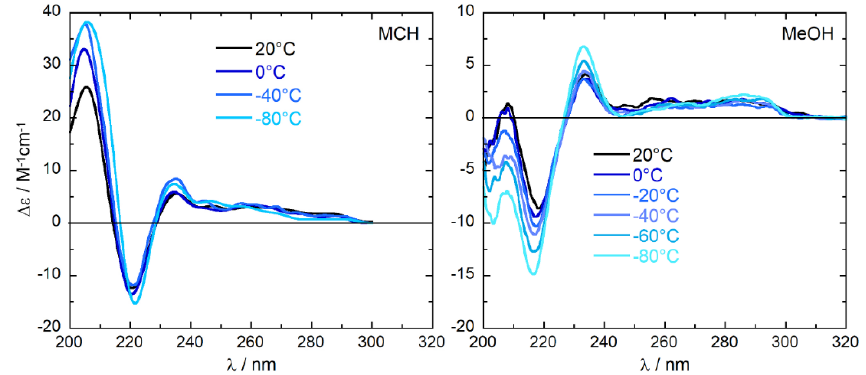
Figure 3. ECD spectra of ( R )-tolterodine ( 1 ) measured in MCH and MeOH at variable temperatures. Concentration 1.67 × 10 − 4 M, cell path length 0.1 cm.